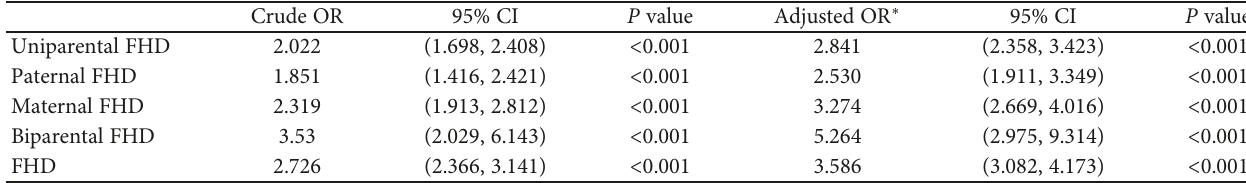
Table 3: Associations of T2DM with a parental history of